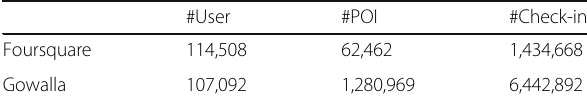
Table 2 Statistics of two